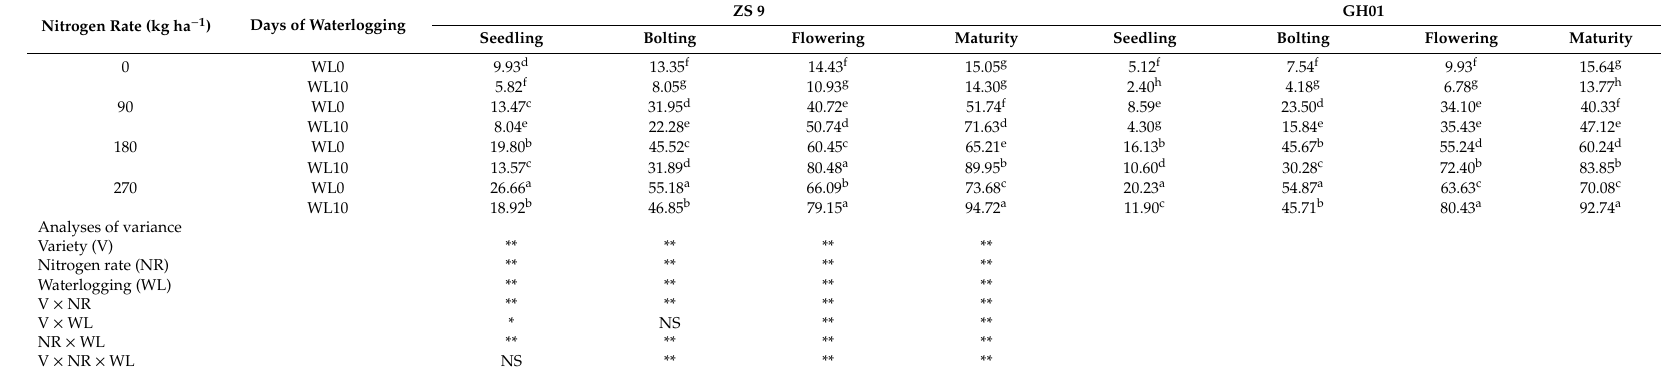
Values followed by di ff erent letters within the same column are significantly di ff erent at the 0.05 probability level according to LSD test; WL0, plants without waterlogging; WL10, plants waterlogged for 10 days at the seedling stage. * Significant at the 0.05 probability level. ** Significant at the 0.01 probability level. NS, not significant according to